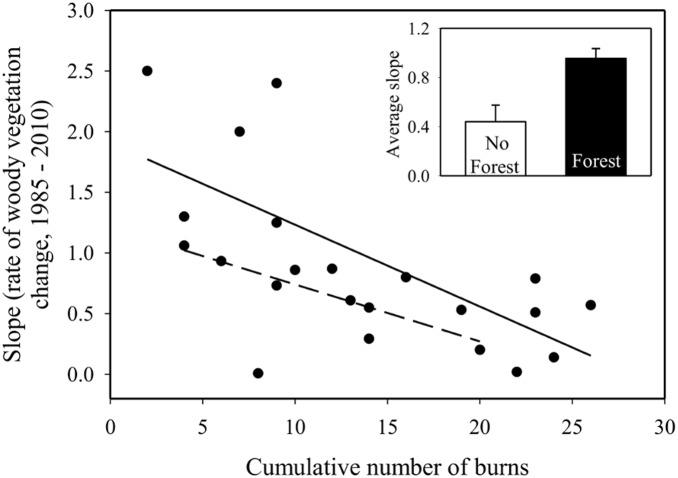
The association between the linear regression slopes calculated for each watershed’s change in riparian vegetation from 1985–2010 and the cumulative number of burns since 1980 using a multiple, linear regression model.Separate regression lines are present for watersheds without riparian woody vegetation present (open circles, dotted line), and watersheds with riparian, woody vegetation present historically (closed circles, bold line). The average slope of watersheds (rate of woody riparian expansion) with riparian forest was greater than those without forest historically (upper right panel).